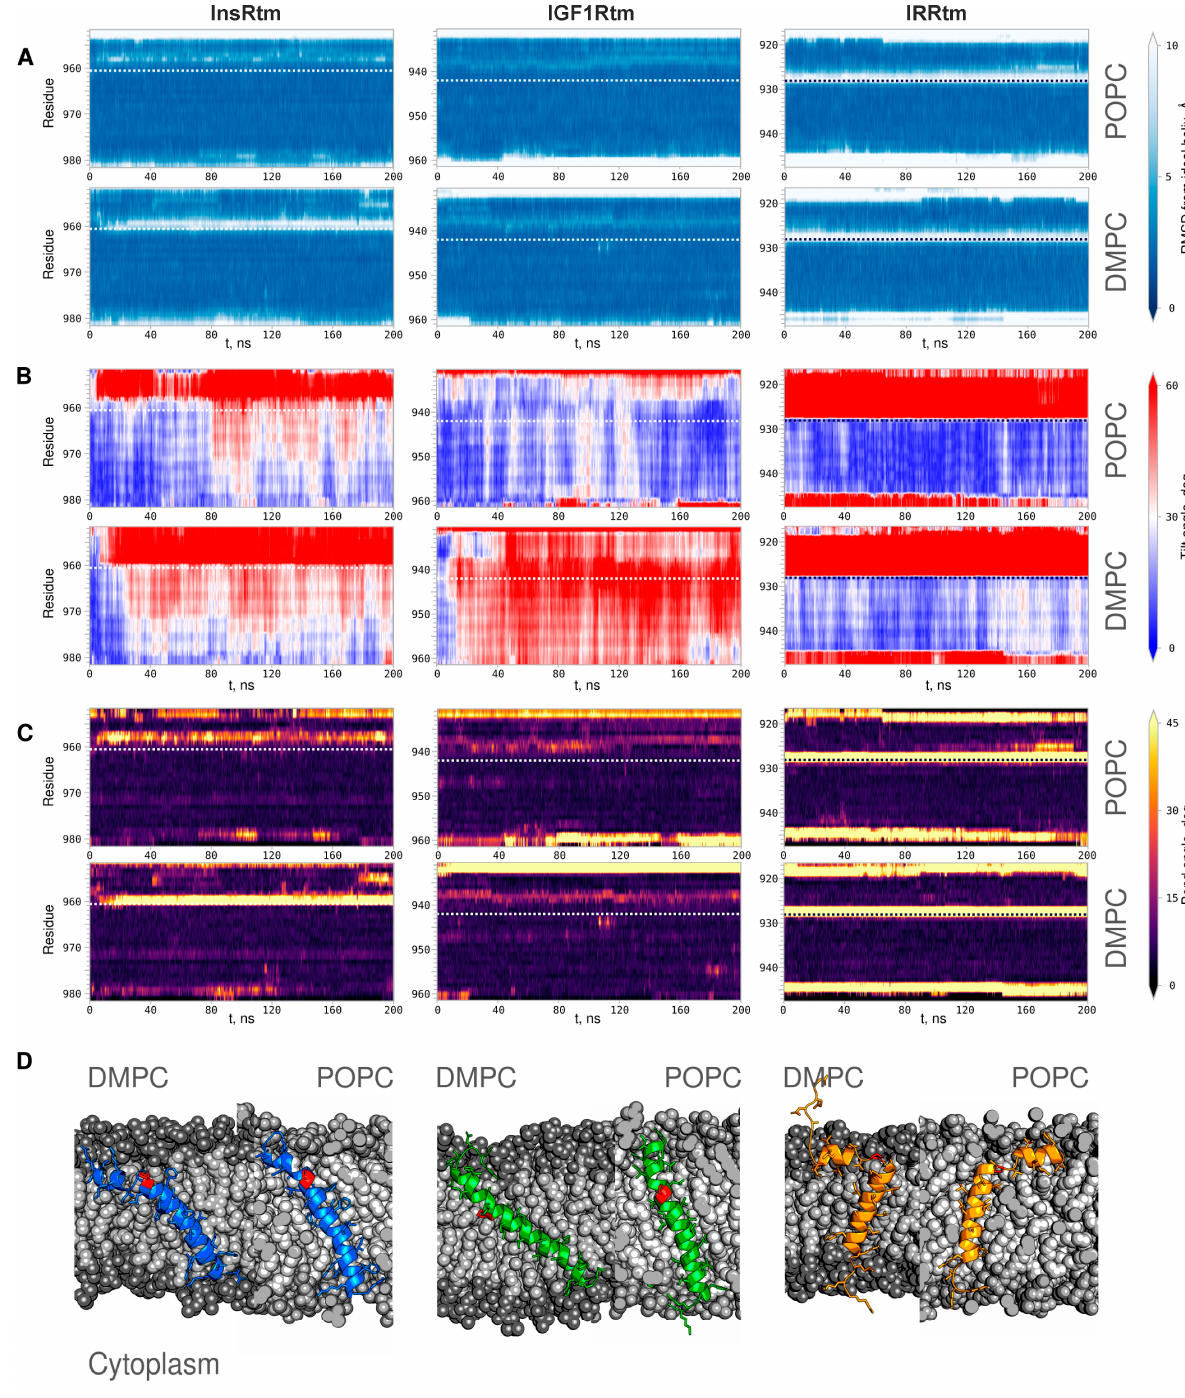
Figure 3. Conformational behavior of InsRtm, IGF1Rtm, and IRRtm during MD simulations in hydrated lipid bilayers composed of DMPC and POPC. Color-coded maps present time evolution of ( A ) RMSD from the ideal helix for the secondary structure, ( B ) local helix tilt angle of TMDs during MD simulations, ( C ) local helix bending of InsRtm, IGF1Rtm, and IRRtm relaxed in DMPC (bottom panels) and POPC (top panels) bilayers. On the right, the color-coding bars of the corresponding values are presented. ( D ) Representative MD snapshots of the InsRtm, IGF1Rtm, and IRRtm structures relaxed in DMPC (left) and POPC (right) bilayers (shown by gray spheres). TMD fragments are given as ribbon representation in blue (InsRtm), green (IGF1Rtm), and yellow (IRRtm); intramembrane proline residues are shown in